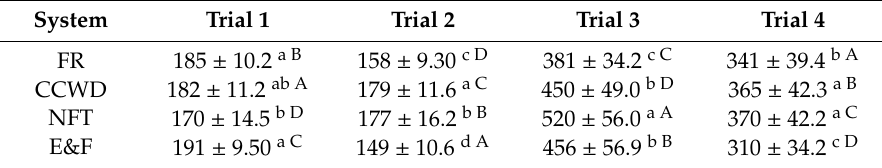
Table 1. Average light intensity ( µ mol m − 2 s − 1 ) recorded in each aquaponic growing system throughout the experiment.